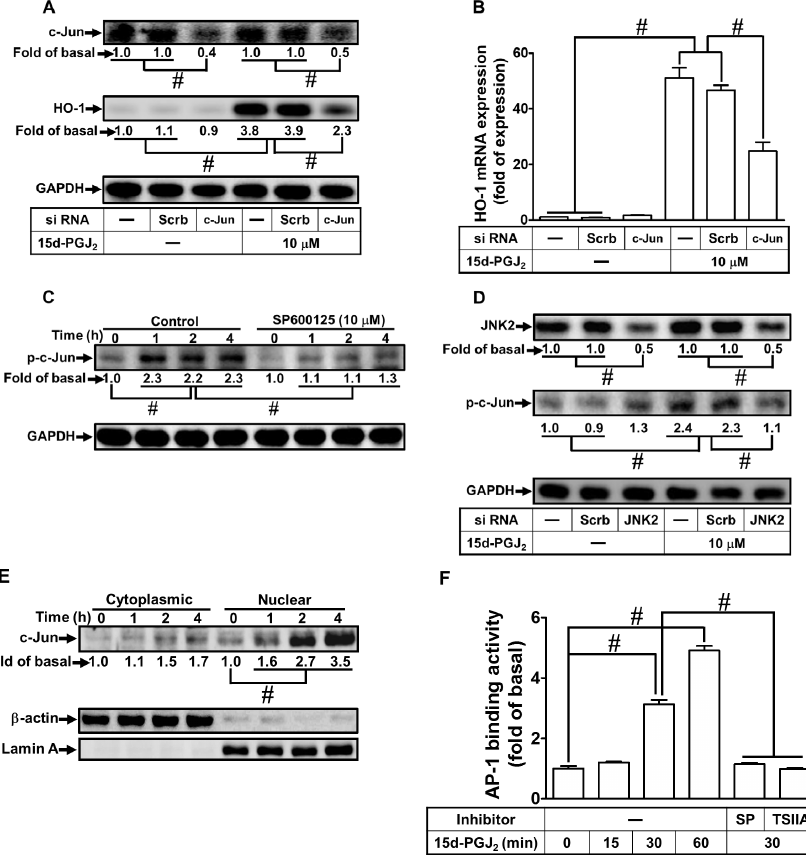
Figure 6. Involvement of transcription factor c-Jun in the expression of HO-1 induced by 15d-PGJ 2 in bEnd.3 cells. ( A , B ) The cells were transfected with scrambled or c-Jun siRNA and then challenged with 15d-PGJ 2 (10 µ M) for 6 h ( A ) or 4 h ( B ). ( A ) The levels of HO-1 protein expression were analyzed by Western blot with GAPDH as an internal control. ( B ) The HO-1 mRNA expression was analyzed by real-time PCR. ( C ) bEnd.3 cells were pretreated with SP600125 (10 µ M) for 1 h and then administrated with 15d-PGJ 2 (10 µ M) for 1, 2, and 4 h. The phosphorylation of c-Jun was determined by Western blot with GAPDH as an internal control. ( D ) The bEnd.3 cells were transfected with scrambled or JNK2 siRNA and then challenged with 15d-PGJ 2 (10 µ M) for 4 h. The phosphorylation of c-Jun was examined by Western blot with GAPDH as an internal control. ( E ) bEnd.3 cells were stimulated with 15d-PGJ 2 for 1, 2, and 4 h. The cells were harvested, and cytosolic and nuclear fractions were separated by centrifugation. The nuclear and cytoplasmic fractions were analyzed by Western blot to evaluate the c-Jun expression, with GAPDH (cytosol) and Lamin A (nucleus) as internal controls. ( F ) bEnd.3 cells were stimulated with 15d-PGJ 2 for 15, 30, and 60 min alone or 30 min while cells were pretreated with Tanshinone IIA (3 µ M) or SP600125 (10 µ M) for 1 h. The binding of c-Jun to the promoter region of HO-1 was determined by a ChIP assay. Data are expressed as the mean ± S.E.M. of three independent experiments. # p < 0.01, as compared with the basal level or the cells treated with 15d-PGJ 2 alone. Abbreviations: AP-1: activator protein 1; TSIIA: Tanshinone